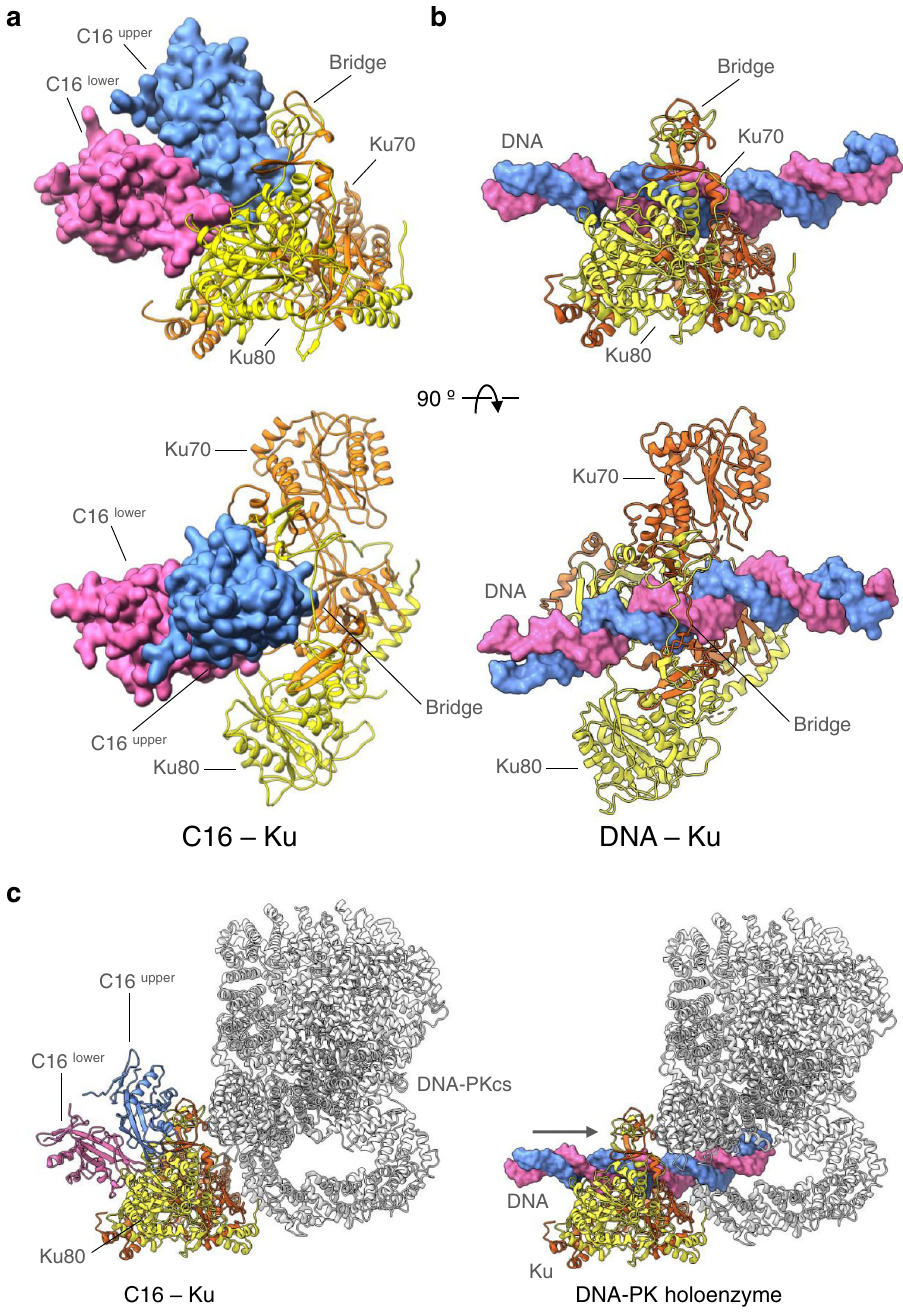
Fig. 5 | C16 sterically blocks DNA binding. a Structure of the C16-C – Ku complex obtained by cryoEM to be compared with b. Ku is shown in ribbons and C16-C is representedasspace- fi llingmodel. b KuboundtoanextendedDNAmoleculeinthe context of its complex with DNA-PKcs (PDB code 5Y3R)(DNA-PKcs is not repre- sented in the panel) 8 to be compared with a. The C16 dimer blocks the path of the